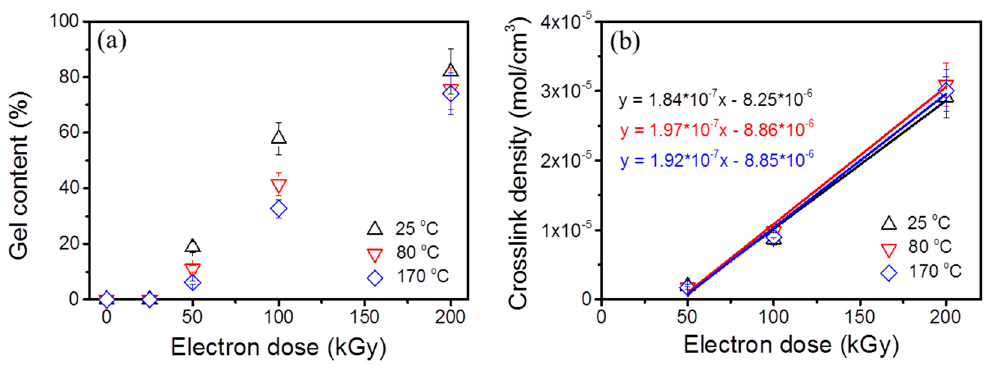
Figure 4. ( a ) Gel content of irradiated mNR with various applied temperatures and doses; ( b ) Variation of crosslink density with dose.